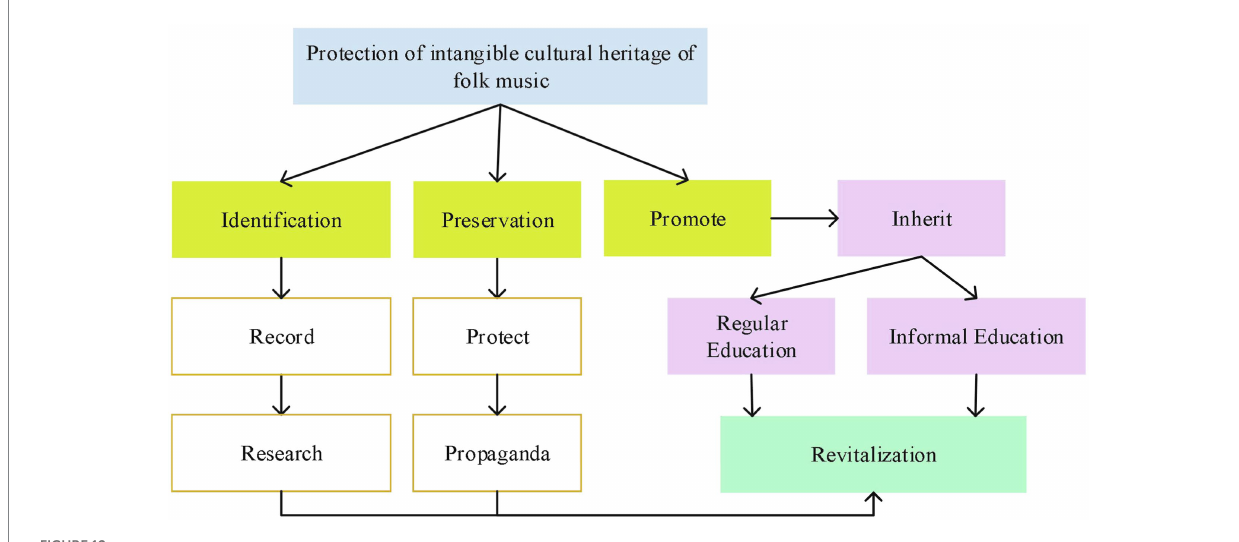
FIGURE 12 Ways to safeguard the ICH of folk